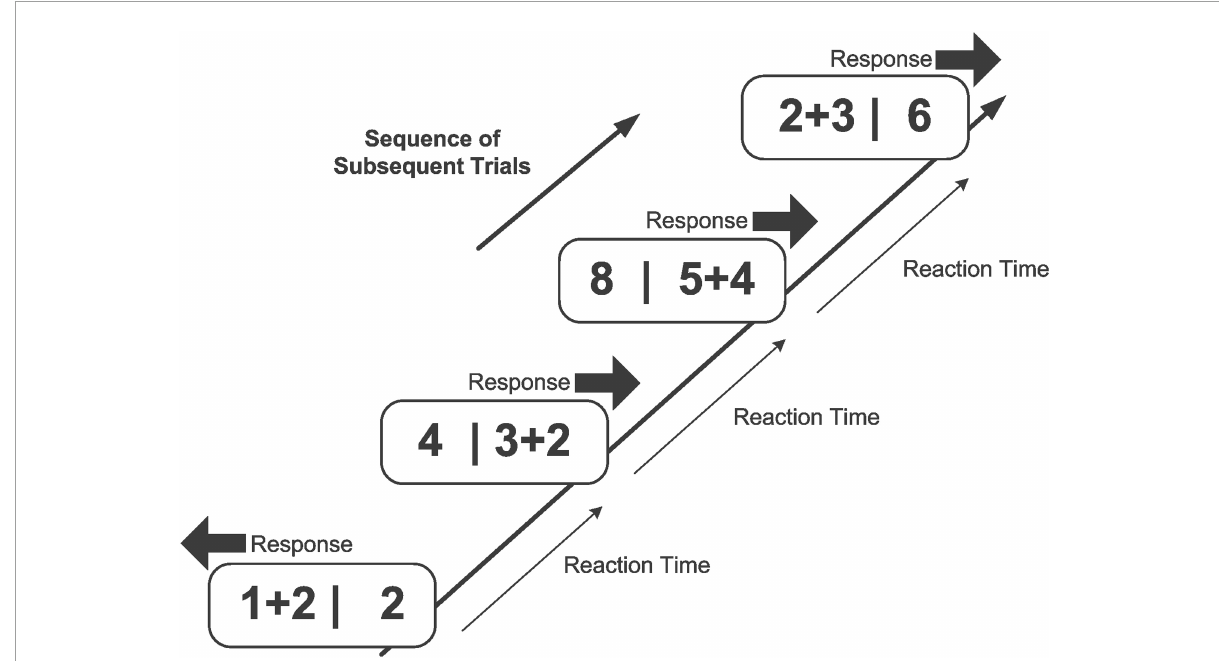
FIGURE2 Example of a series of trials in the mental addition and comparison task. The task is to solve the addition term (e.g., “2 + 3 = ... ?”) and to decide whether the result is larger or smaller than the presented number value (e.g., “5 > 6 ... ?”). The participants are to respond by “choosing” the larger of the number values. Each item in the task is presented immediately after the response to the previous